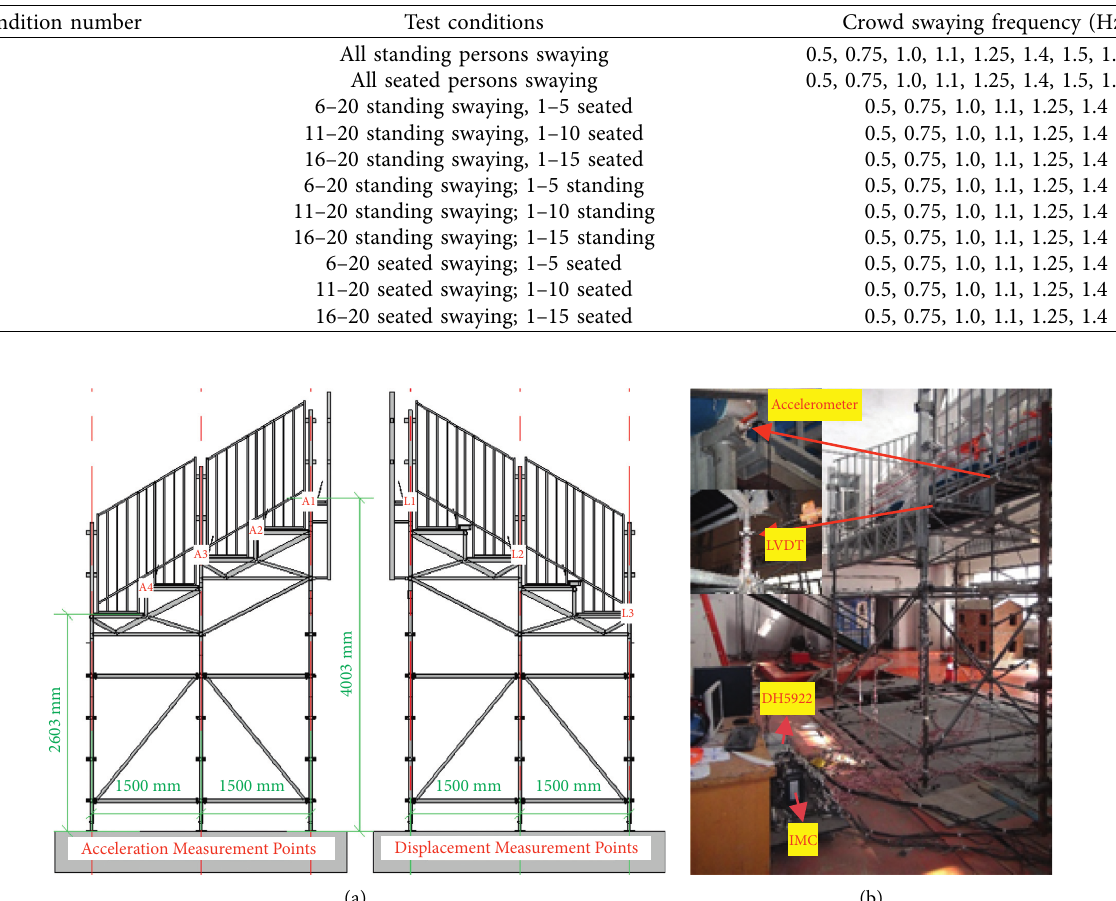
Table 2: Details of crowd rhythmic activities.